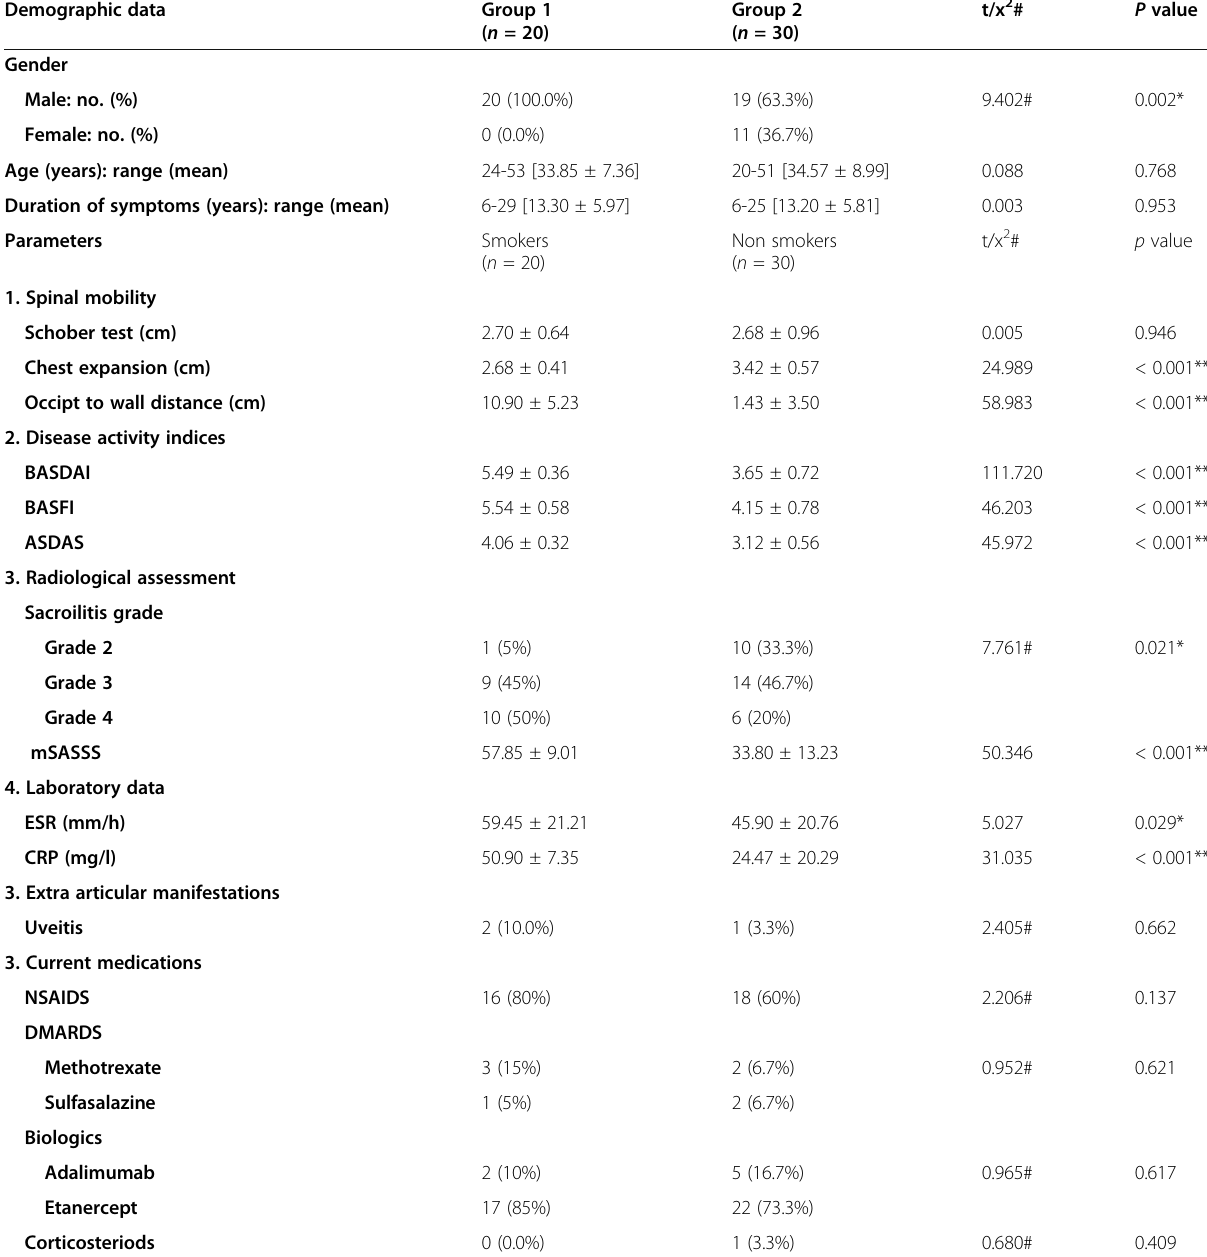
Table 2 Comparison between smokers and non-smokers AS groups regarding demographic and clinical data Demographic